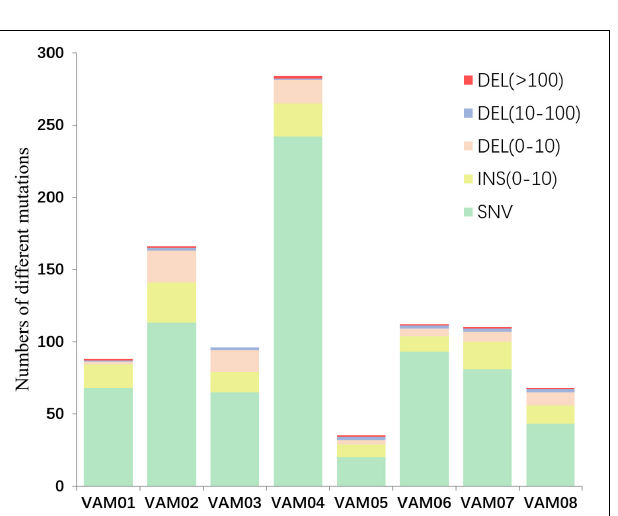
FIGURE 4 | The numbers of different mutations in eight PRM strains from V. alginolyticus . The mutations were classed into insertion (INS), deletions (DEL), and single nucleotide variations (SNVs) according to the mutation types and sizes. An 11-bp insertion in the PRM strain VAM03 was not shown in